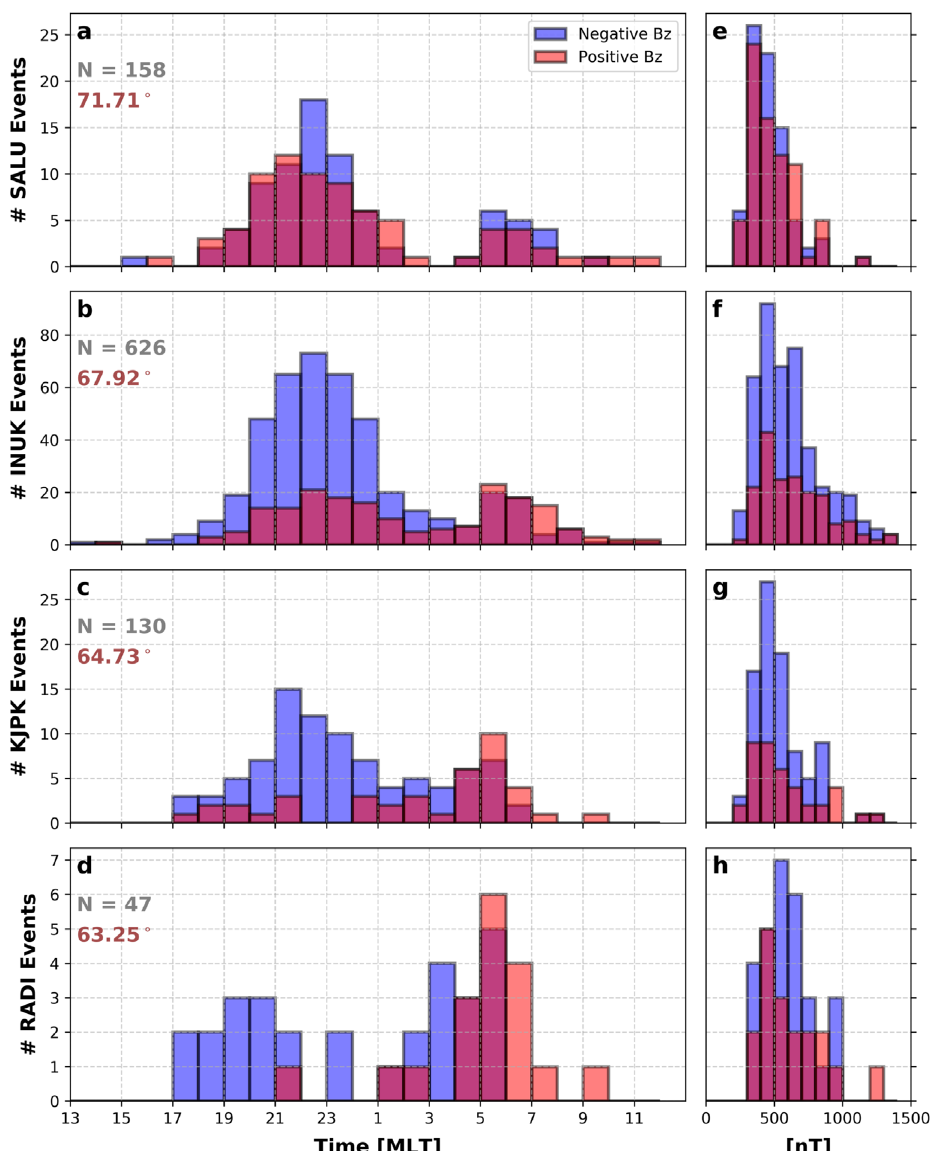
Fig. 4. Left (a)-(d): Magnetic local time distribution of impulsive events per hour as recorded at selected AUTUMNX locations. Right (e)-(h): Distribution of magnitude of 8-min B z ranges around identi fi ed impulsive events per 100 nT bin. Vertical scales vary between magnetometers to better convey diurnal trends. Total event numbers are indicated in bold gray for each magnetometer, with corrected geomagnetic latitude indicated in dark red indicated underneath. Blue shading indicates negative impulses, red shading